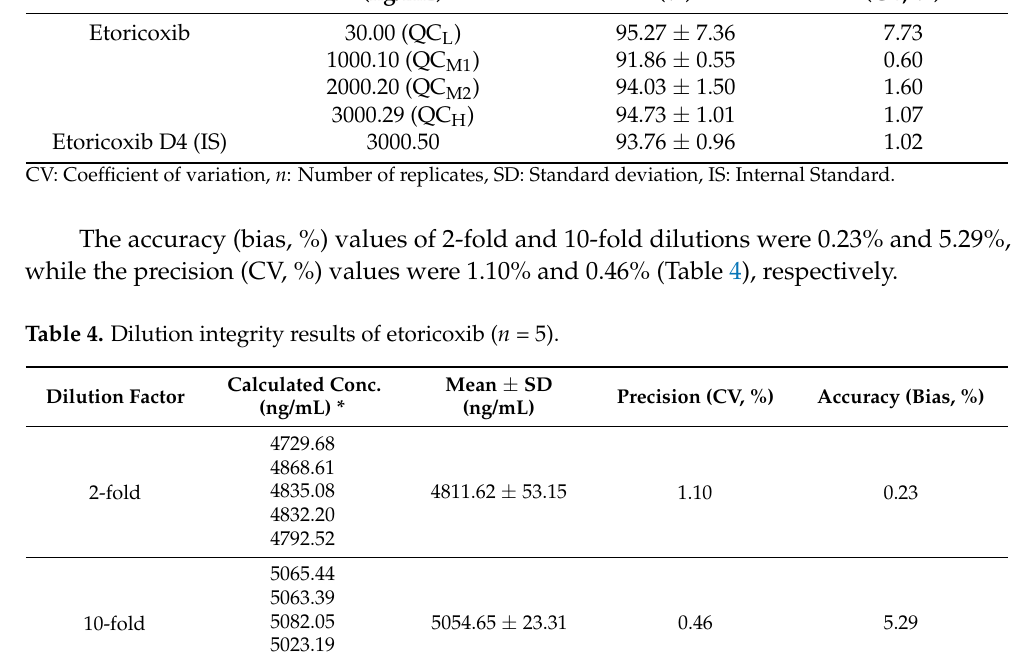
Nominal Concentration (ng/mL)